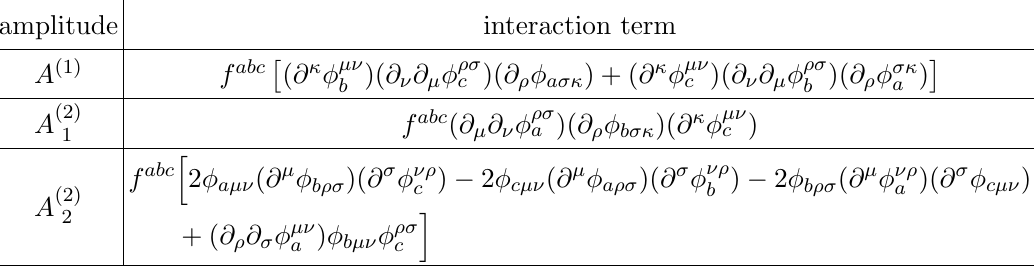
Table 5 . Amplitudes and the corresponding interaction